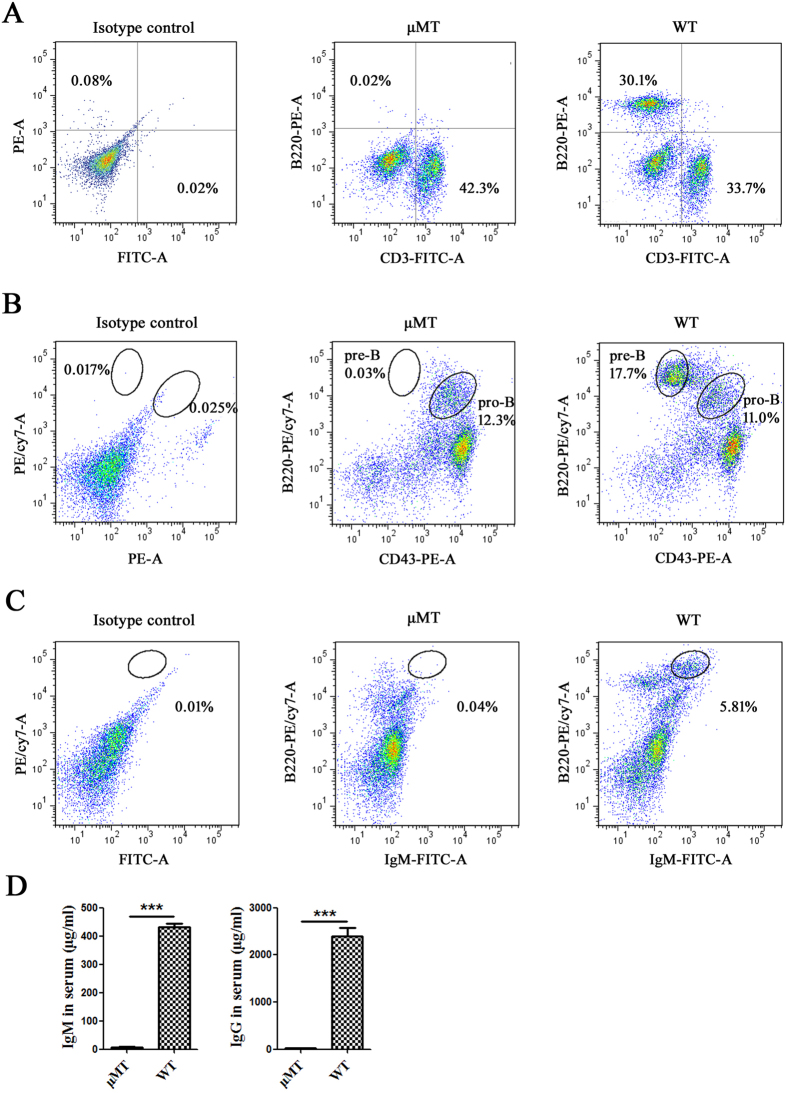
Identification of B cells and Igs in μMT mice.(A) B lymphocyte and T lymphocyte in peripheral blood of WT mice and μMT mice were detected with PE anti-mouse B220 and FITC anti-mouse CD3 by FACS. (B) Pro-B cell (CD43+ B220low) and pre-B cell (CD43− B220+) in BM of WT mice and μMT mice were detected with PE anti-mouse CD43 and PE/Cy7 anti-mouse B220 by FACS. The cells in the upper left circle were pre-B cells, and the cells in the bottom right circle were pro-B cells. (C) Mature B cell (B220+ IgM+) in BM of WT mice and μMT mice were detected with FITC anti-mouse IgM and PE/Cy7 anti-mouse B220 by FACS. The circle showed mature B cells. (D) The concentrations of IgM and IgG in serum from WT mice and μMT mice were detected by ELISA. ***P < 0.001, **P < 0.01, ns P > 0.05.